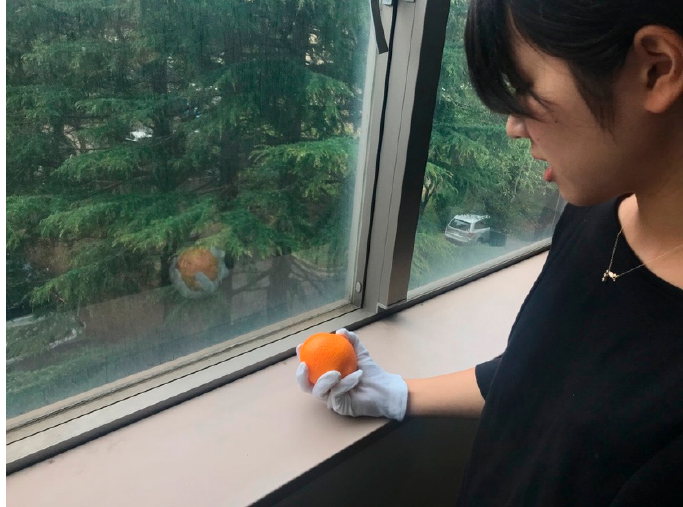
Figure 5. Natural illumination condition (next to a north window).